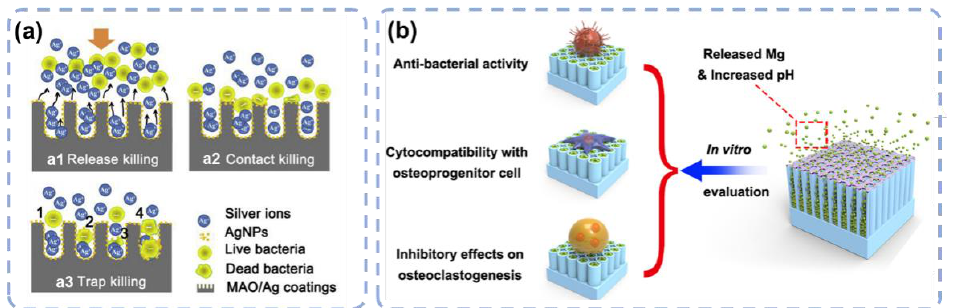
Figure 5. ( a ) The incorporation of Ag nanoparticles in TiO 2 microporous structures to conduct bacteria killing. a1: Releasing of Ag nanoparticles to kill the bacteria; a2: Killing of bacteria upon contact with Ag nanoparticles at the TiO 2 microporous structures; a3: Killing of the bacteria by trapping them in the microporous structures. Reprinted with permission from Ref. [62]. Elsevier, 2016. ( b ) The incorporation of Mg into TiO 2 nanotubes to achieve both antibacterial and osteogenesis purposes. Reprinted with permission from Ref [78]. American Chemical Society, 2019.